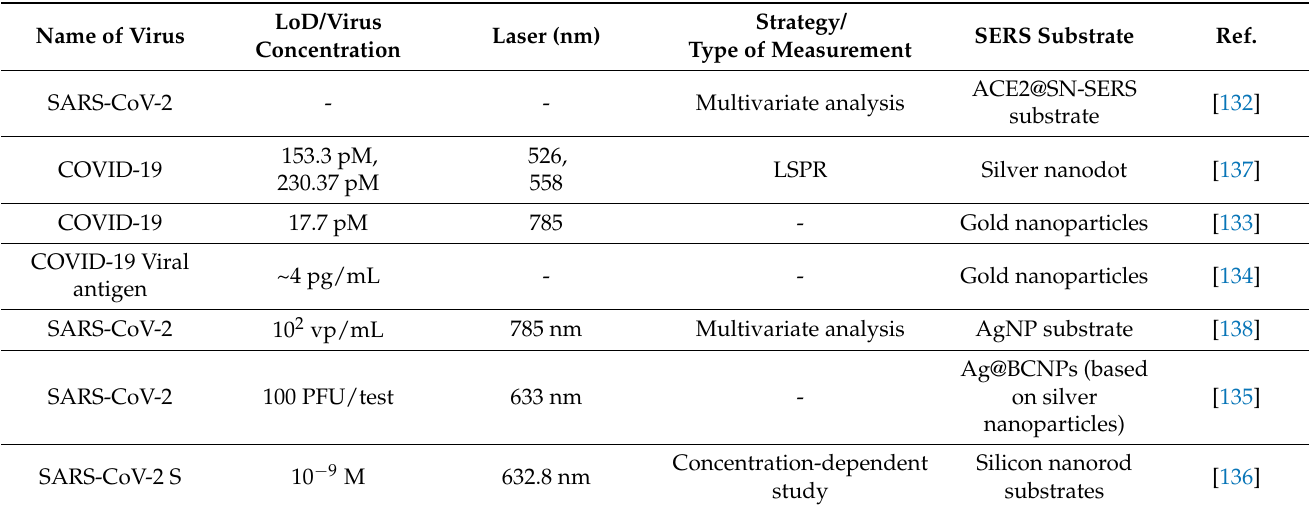
Table 3. Representative studies of the coronaviruses (COVID-19 and SARS CoV-2) by